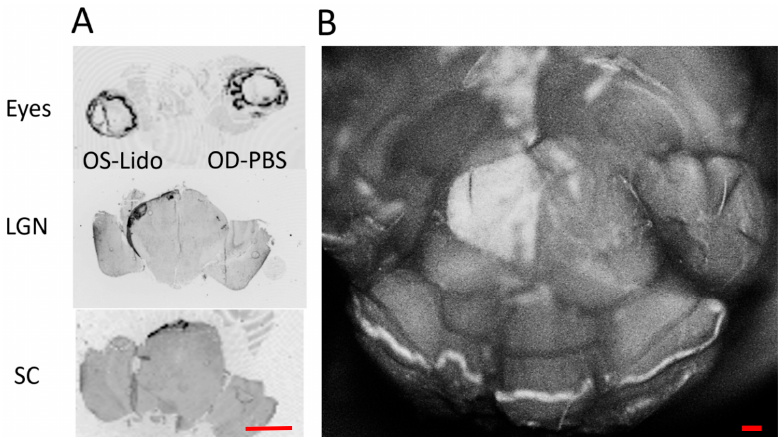
Figure 1 . Retrobulbar lidocaine blocks axon transport. ( A ) Representative consecutive tissue sections from the eyes to the brain one day after retrobulbar lidocaine in the left eye, immediately followed by intravitreal injection of Alexa Fluor 488 Cholera Toxin B in both eyes. Fluorescence is evident in both eyes but it is absent in the lateral geniculate nucleus (LGN) and Superior Colliculi (SC) contralateral to the left eye. Fluorescence is present in the LGN and SC contralateral to the phosphate-buffered saline (PBS)-injected right eye; scale bar, 200 µm. ( B ) Confocal scanning laser ophthalmoscopy of the midbrain surface. The entire surface of the right SC receiving afferents from the lidocaine- injected right eye does not fluoresce, indicating impairment of axon transport in the lidocaine-treated eye; scale bar, 200 µm.